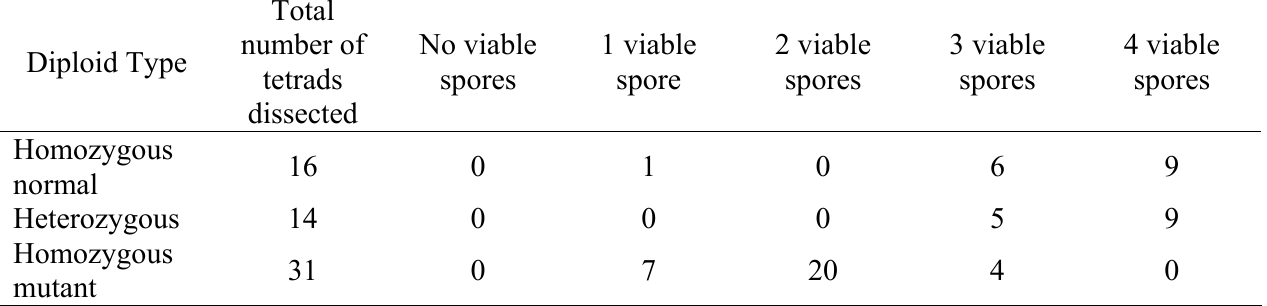
Table 2a. Viability of spores from BLM1 / BLM1 , BLM1 / blm1-1 , and blm1-1 / blm1-1 diploid strains